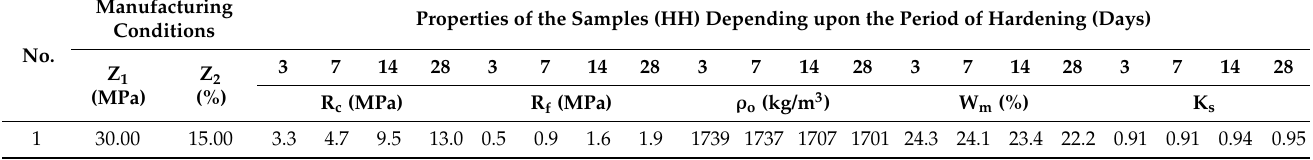
Table 7. Experimental data of the properties of the experimental samples (HH) not subject to the initially forced carbonisation and hardened within 28 days. Manufacturing No.